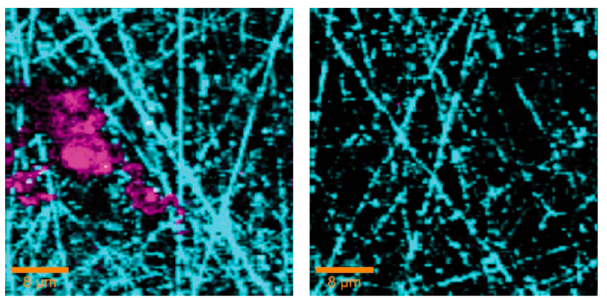
Figure 12. Color-coded Raman images for Zn exposed to 115 ppb acetic acid for 48 h in humid ( left ), and dry conditions ( right ). Purple color represents zinc hydroxy acetate (integrated 2850–3000 cm − 1 ) and blue color ZnO (300–650 cm − 1 ). The image size is 40 × 40 μ m. Reproduced from reference [105] by permission of The Electrochemical Society. Copyright 2010.